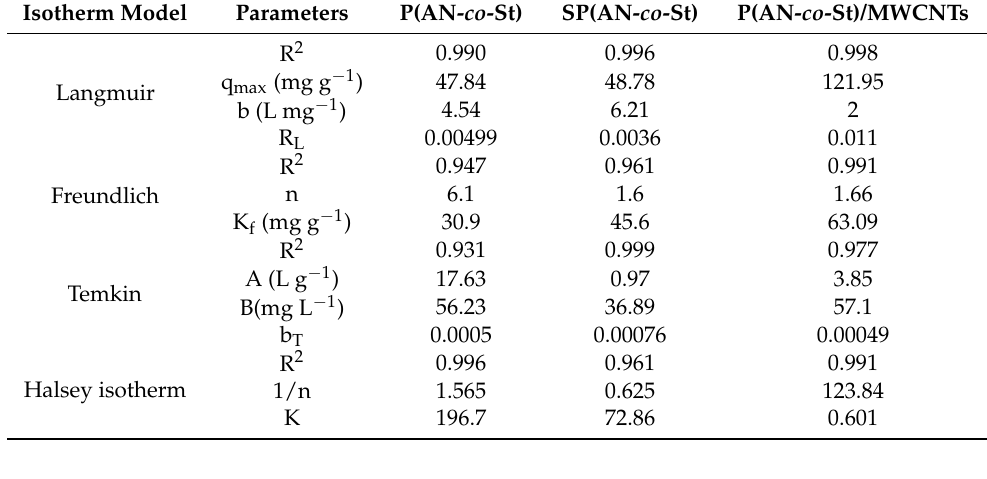
Table 4. Isotherm parameters for the removal of MO dye on different nanocomposites.